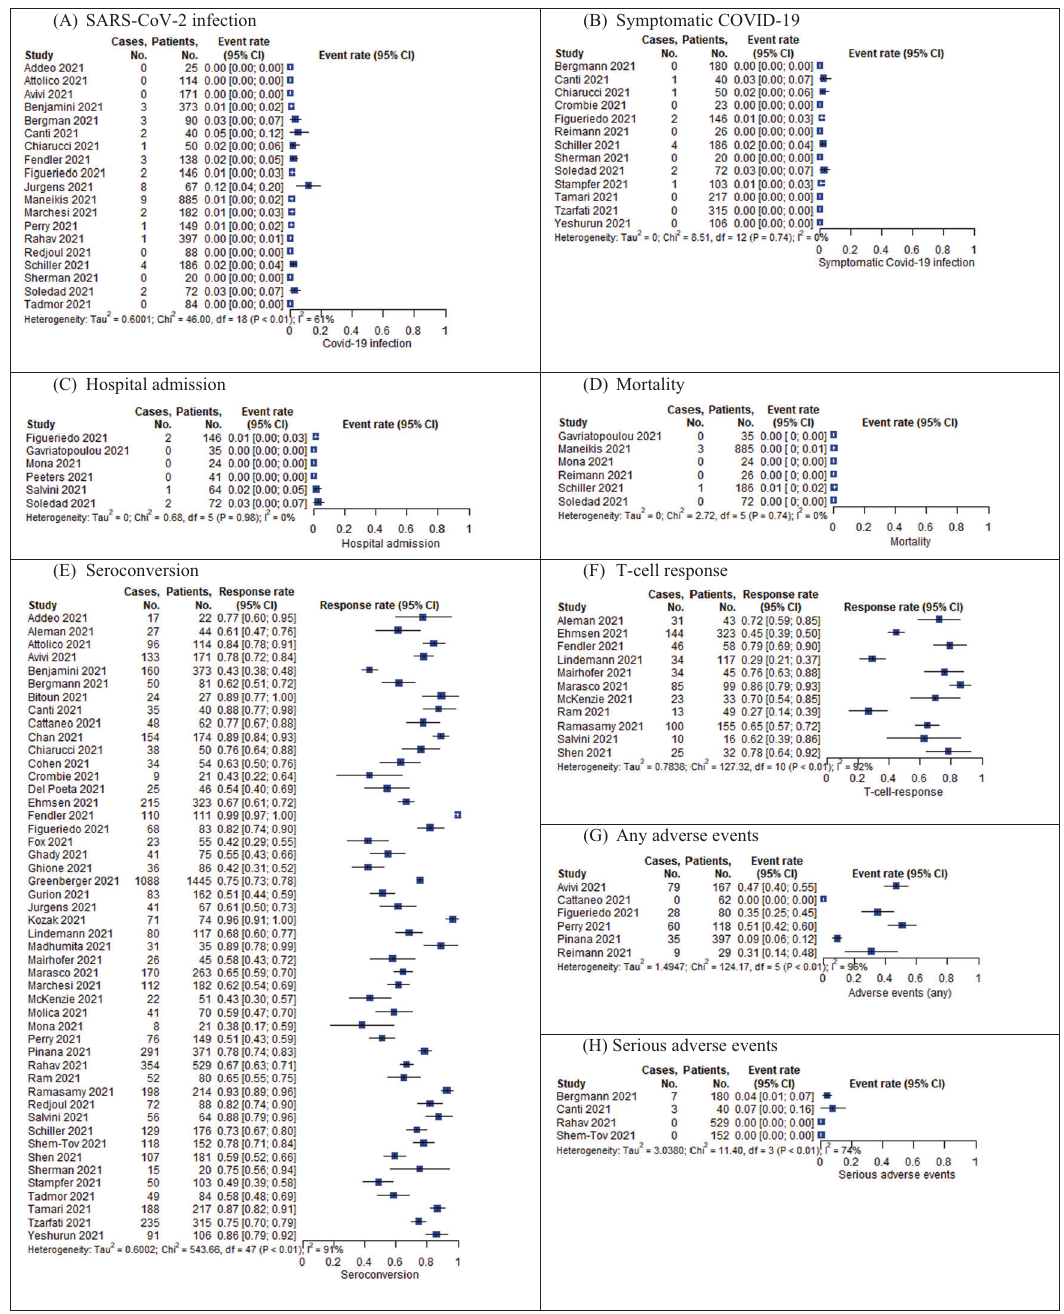
Fig. 2 Event and response rate for prioritized outcomes per study. A SARS-CoV-2 infection, B symptomatic COVID-19, C hospital admission, D mortality, E seroconversion, F T-cell response, G any adverse events, H serious adverse